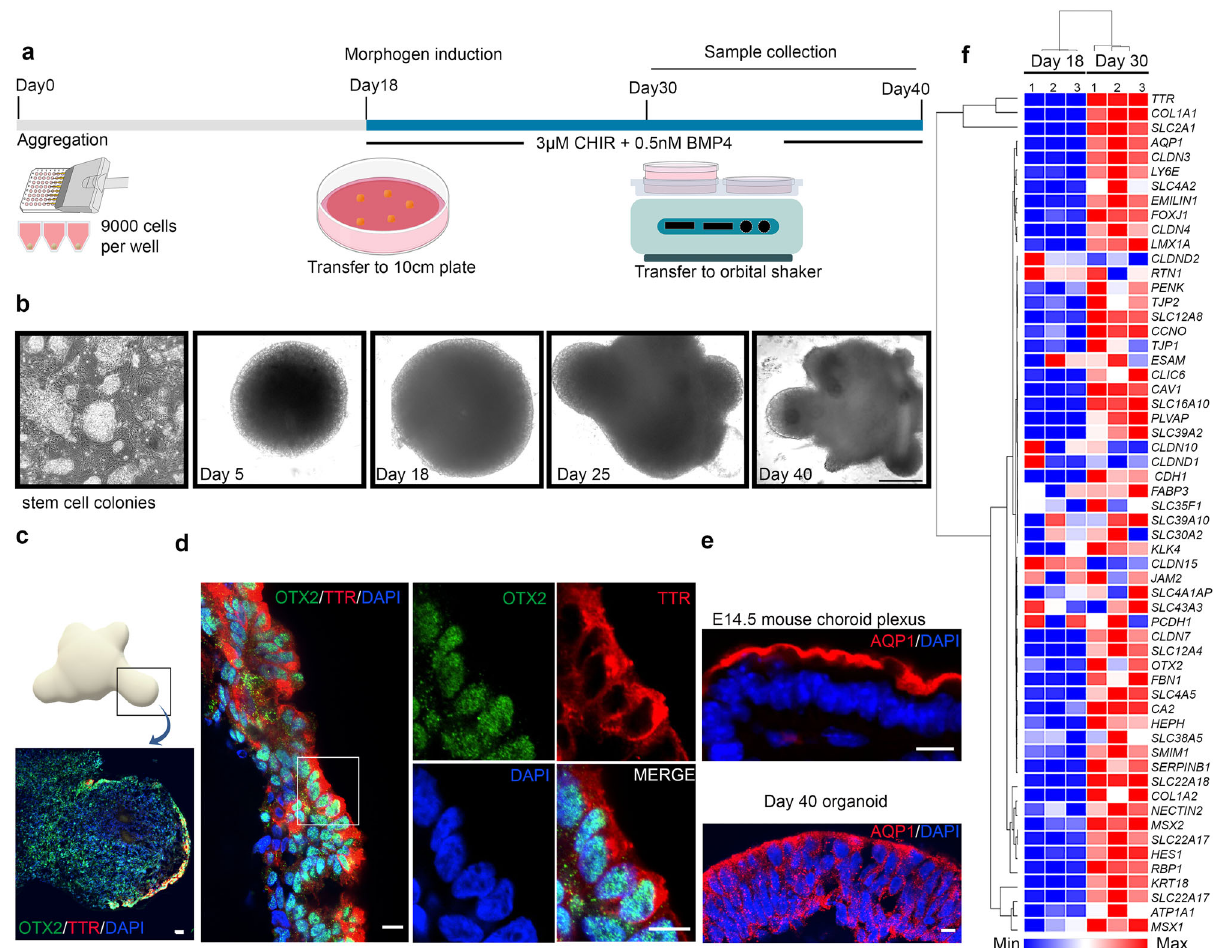
Fig. 9 Differentiation of hESC organoid cultures using a ChPe differentiation-promoting protocol. a Schematic presentation describing the organoid culture protocol. (b) Bright- fi eld images of organoids at different stages of development. Representative images from N = 48 organoids (biologically independent replicates) examined over 3 separate experiments. ( c, d ) Immunostaining reveals the presence of choroid markers OTX2 and TTR in the perimeter of the protrusions of a day 40 organoid. Boxed region ( c, d ) is shown at high magni fi cation in the adjacent panels. ( e ) AQP1 immunostaining in Day 40 organoids is similar to that seen in the E14.5 mouse ChP. ( c – e ) Representative images of sections taken from N = 12 organoids (biologically independent replicates) examined in 2 separate experiments. ( f ) Heatmap and hierarchical clustering generated from normalized reads obtained by MARS- Seq show upregulation of ChP-enriched genes by day 30 of the organoid culture ( N = 3 biologically independent replicates). Scale bars: 200 μ m (all panels in b ); 100 μ m ( c ); 10 μ m (all panels in d and e ). Source data are provided as a Source Data fi